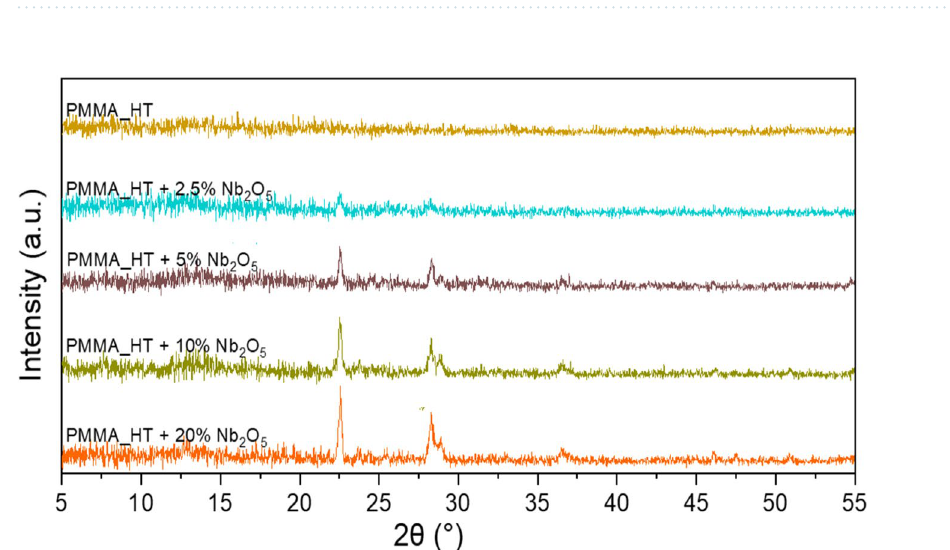
Table 2. Nb 2 O 5 parameters determined using X-ray diffraction.